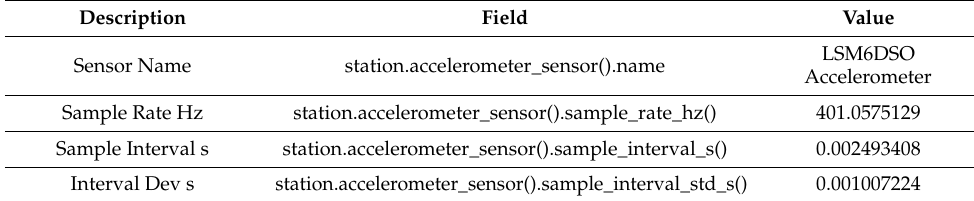
Table 7. Accelerometer Sensor.